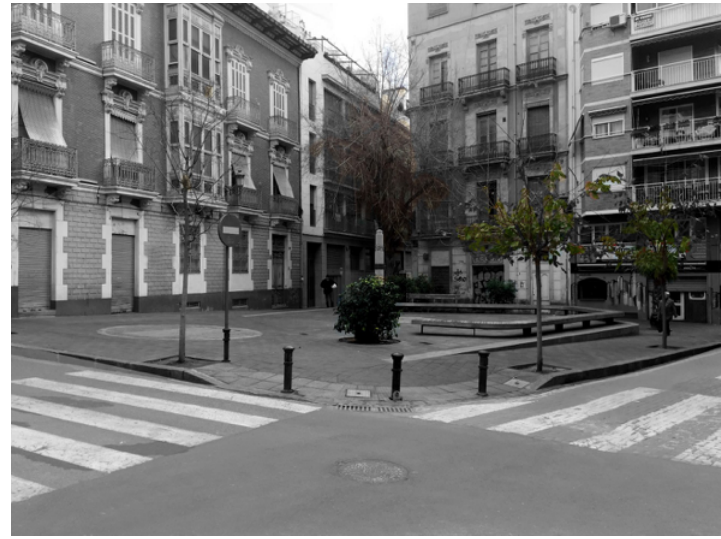
Figure 1. Doctor Balmis Square at